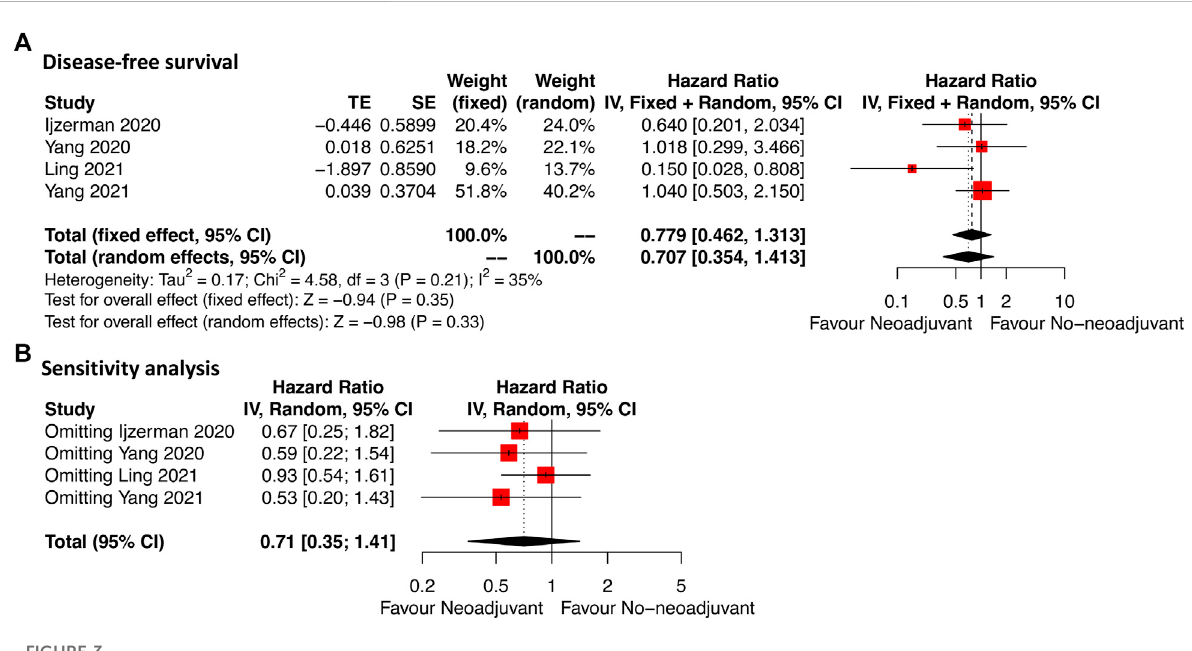
FIGURE 3 Forest plots illustrating disease-free survival between neoadjuvant and no-neoadjuvant imatinib (A) and sensitivity analysis (B)